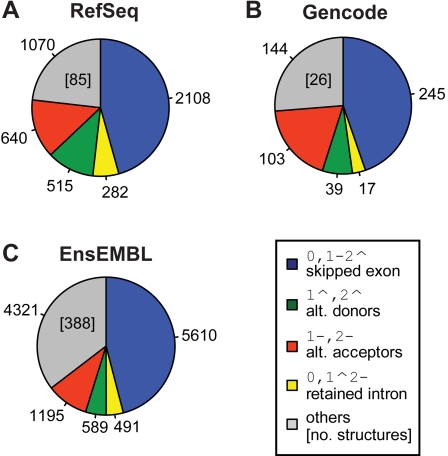
Comparison of the AS landscape in human reference annotations.Distribution of AS events that are not related to alternative transcription starts/polyadenylation sites and contain exclusively introns with canonical splice sites in different reference annotations of the human genome: EnsEmbl, RefSeq, and Gencode. Numbers represent the event count for each different structure and the proportions of the 4 simplest splicing patterns are colored as follows: exon skipping in blue, alternate donors in green, alternate acceptors in red and retained introns in yellow; the fraction of all types of more complex events is shown together in grey with the number of different structures observed there given in brackets. In general, the landscape of AS splicing is similar across the three datasets, with the biggest difference being a comparatively larger fraction of complex events in EnsEmbl.